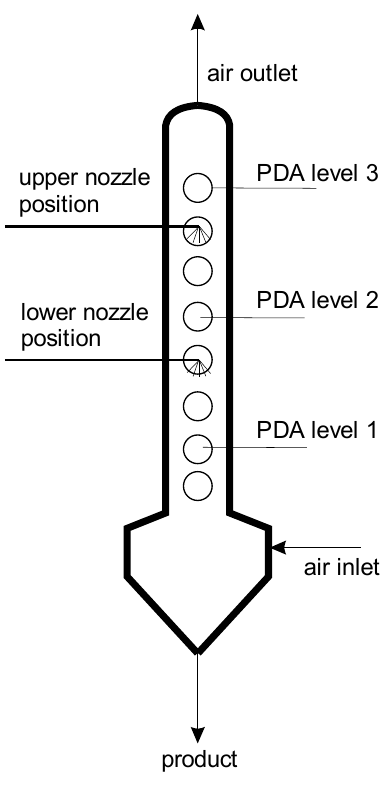
Figure 5. Schematic of pilot plant tower. PDA measurements carried out below and above the nozzle trace changes in particle size distribution and particle velocities at the axis and near the wall (0.22 m from the axis). Downward air flow in the axis area and upward flow near the wall of the tower cause collisions and promote agglomeration of the particles. Figure 6a,b shows the particle size distribution of the product for the nozzles at the top and the bottom positions in the tower. Figure 6a shows that PSD above the nozzle is smaller, both at the axis (D32 = 25.4 µ m) and at the wall (D32 = 78 µ m), in comparison with particles measured below the nozzle (D32 = 69.5 µ m) and at the wall (D32 = 96.6 µ m), which is a result of intensive agglomera- tion in the recirculation zones below the nozzle, whereas smaller and lighter particles were entrained with upward airflow to the cyclones. The presence of a large number of smaller particles at the axis results from airflow hydrodynamics, as swirl flow in the chamber moves bigger particles to the wall of the